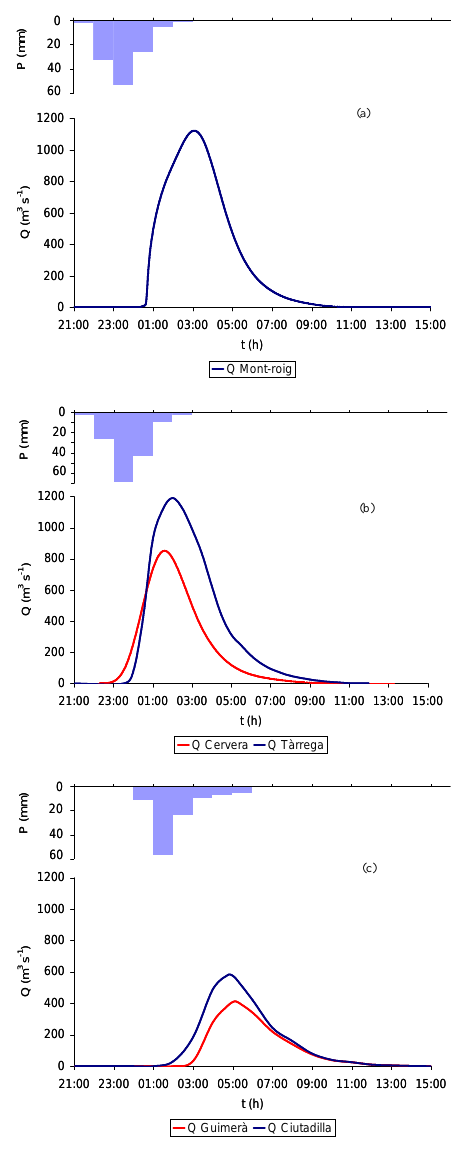
Fig. 9. Reconstructed hyetographs and hydrographs of Si´o at Mont- roig (a) , Ondara at T`arrega and Cervera (b) , and Corb at Guimer`a and Ciutadilla